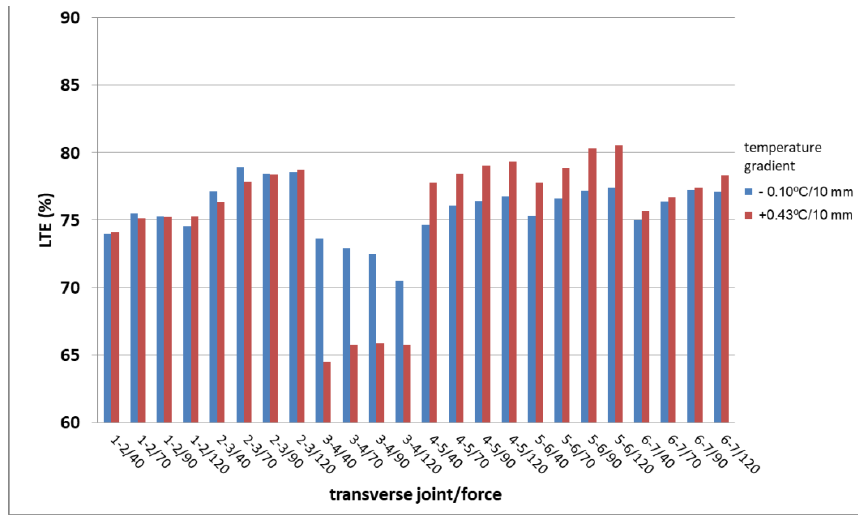
Figure 3. Evaluation of LTE on Highway D1—comparisons of different load and temperature gradients.